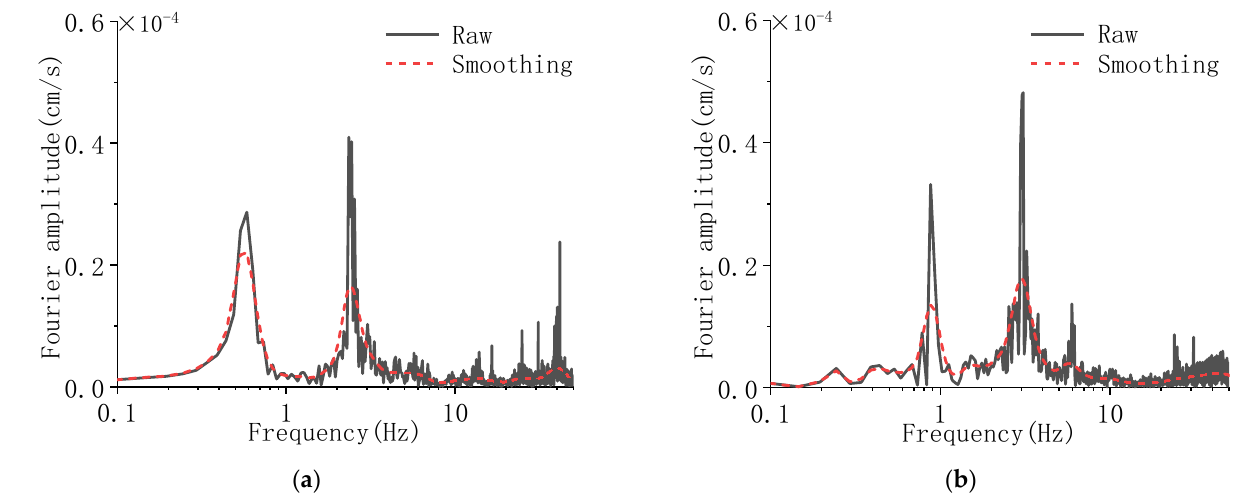
Figure 4. Acceleration time history curves of parts of the original data ( a , c ) before and ( b , d ) after baseline initialization and band-pass filtering.